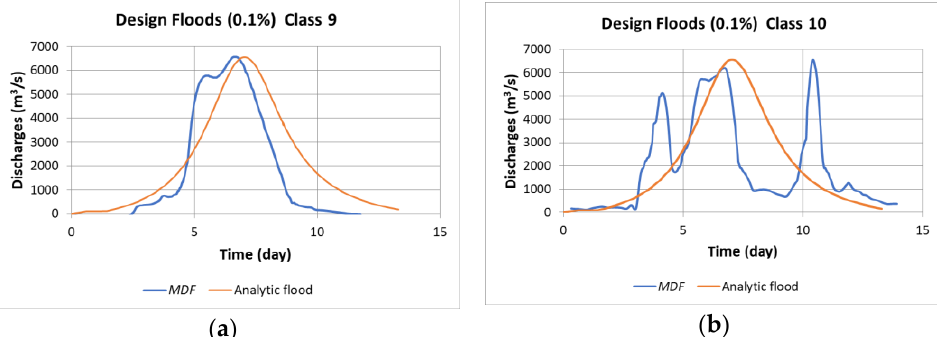
Figure 13. Overlapping MDF s (analytic expression and recorded shape).